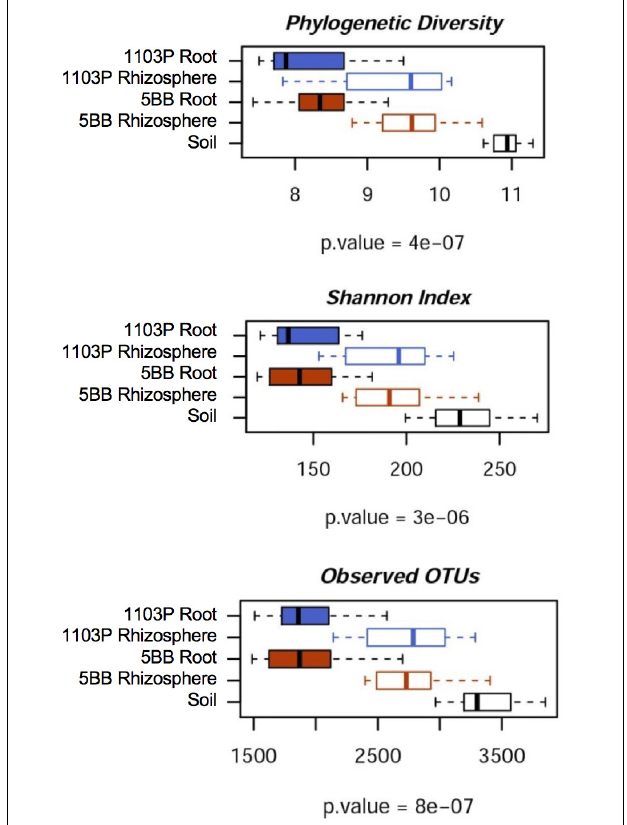
FIGURE 1 | Microbiota biodiversity in soil, rhizosphere, and root compartments for V. vinifera cultivar Lambrusco grafted onto different rootstocks. The OTU table at 0.03 similarity threshold was rarefied up to 10,277 reads per sample and analyzed using the following diversity metrics: Faith’s Phylogenetic Diversity (PD whole tree), the Shannon index of biodiversity and observed OTUs. All metrics show greater microbiota diversity in the soil compared to rhizosphere and root compartments, for both V. vinifera 1103P and V. vinifera 5BB (Kruskal-Wallis test).